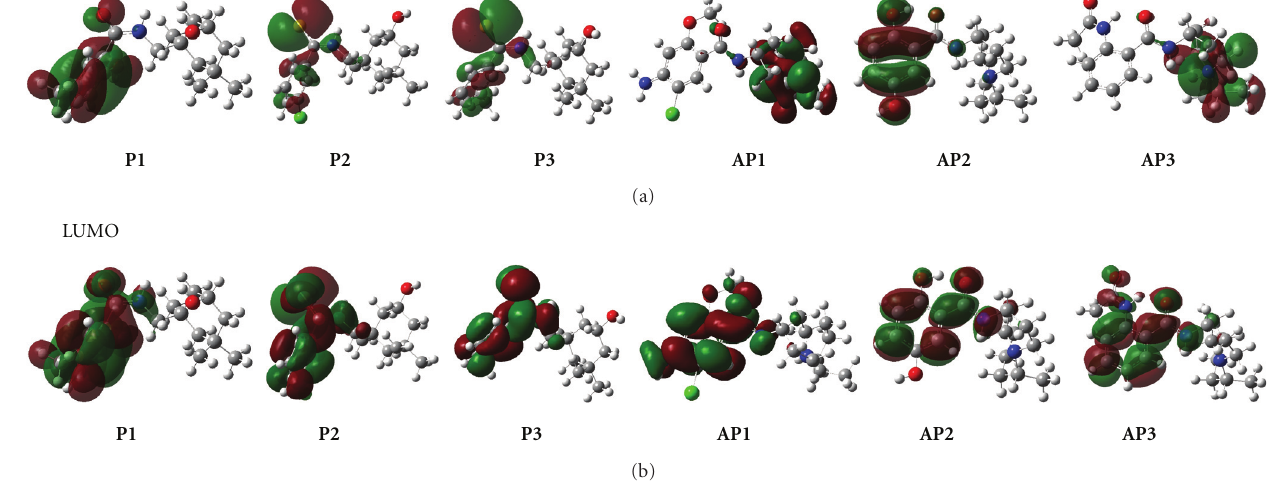
Figure 6: HOMO, LUMO for pharmacophore groups.